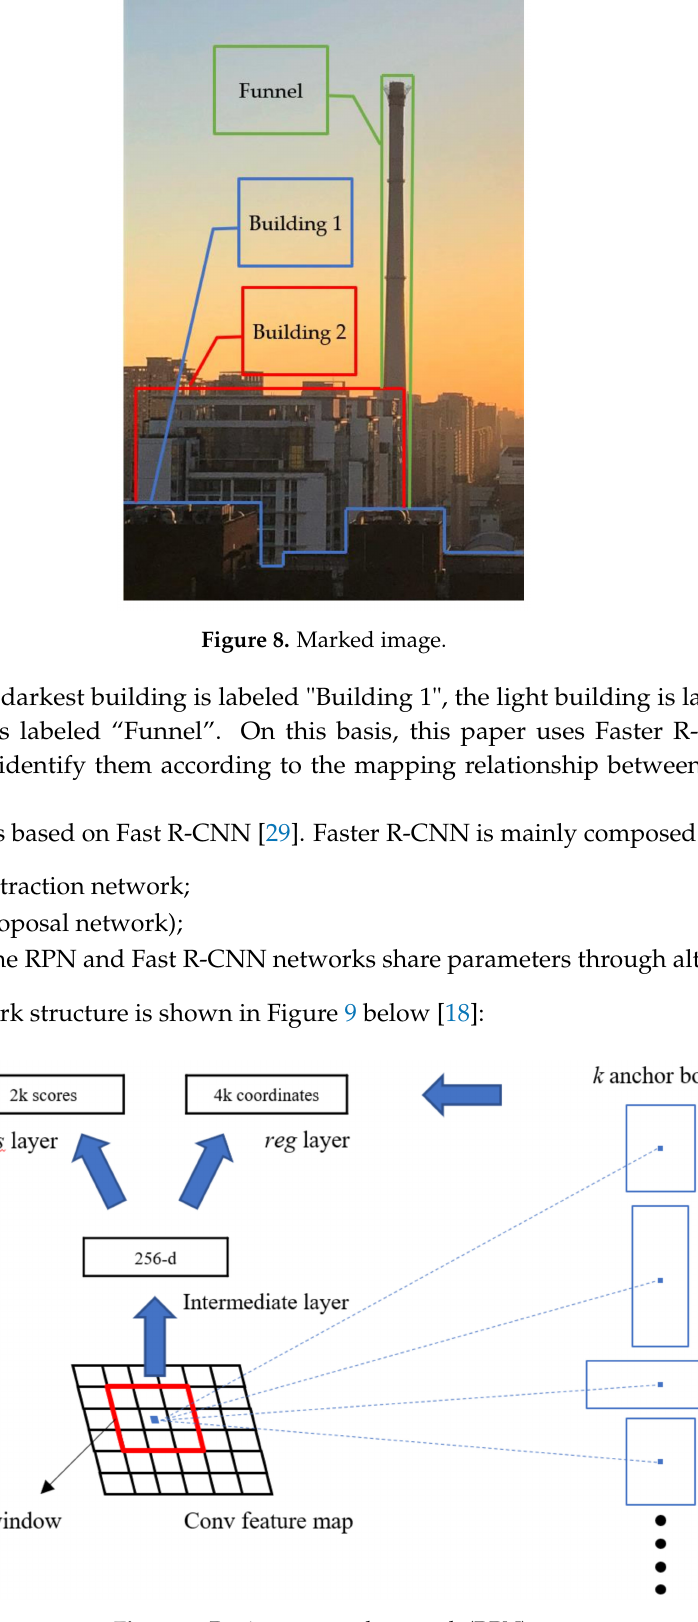
Figure 9. Region proposal network